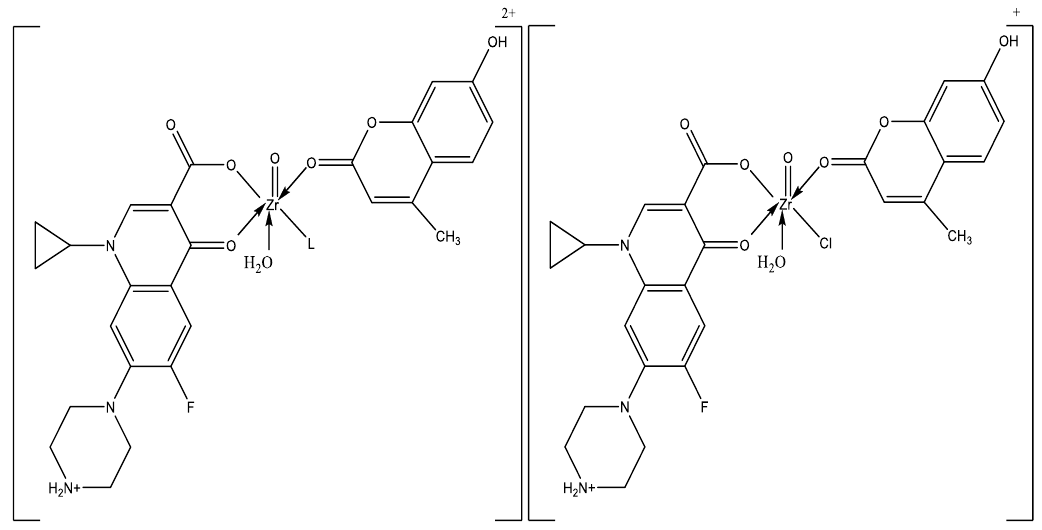
Table 2. Selected infrared absorption frequencies (cm −1 ) for CIP, HMC, and their Zr(IV) complexes (A) , (B) , (C) , and (D)